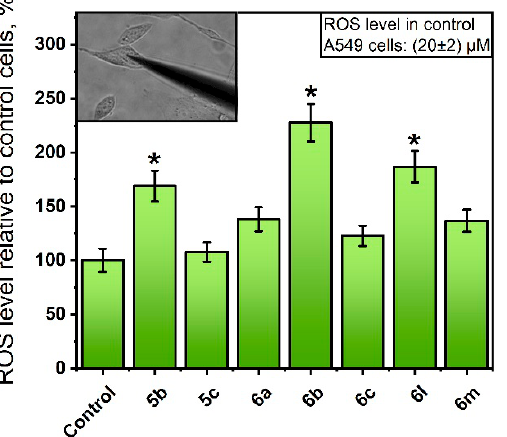
Figure 3. Comparison of the reactive oxygen species (ROS) level inside the A549 cells incubated with compounds 5 and 6 ; *, p < 0.05 (one-way ANOVA).